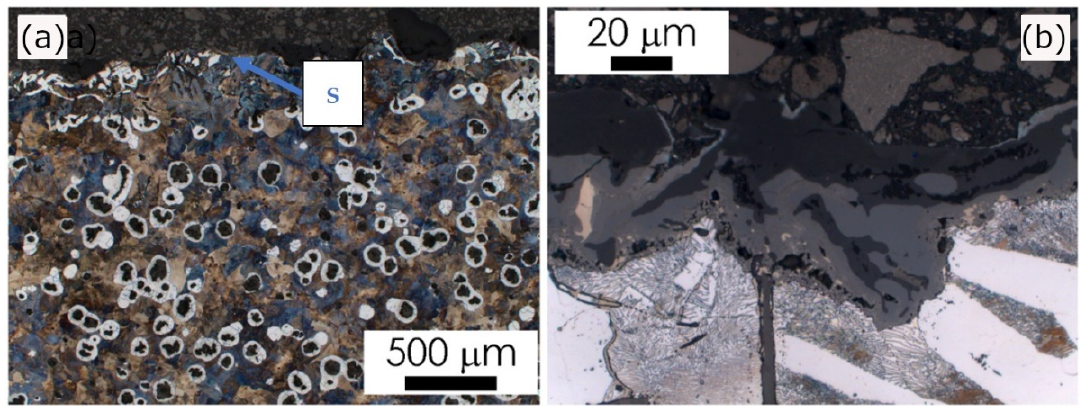
Figure 5. Casting No. 2, prepared in acidic molding sand No. 2, LM etched with 4% Nital; ( a ) microstructure of alloy, microscope magnification 100 × , ( b ) microstructure of the superficial zone (S), microscope magnification 1000 × .